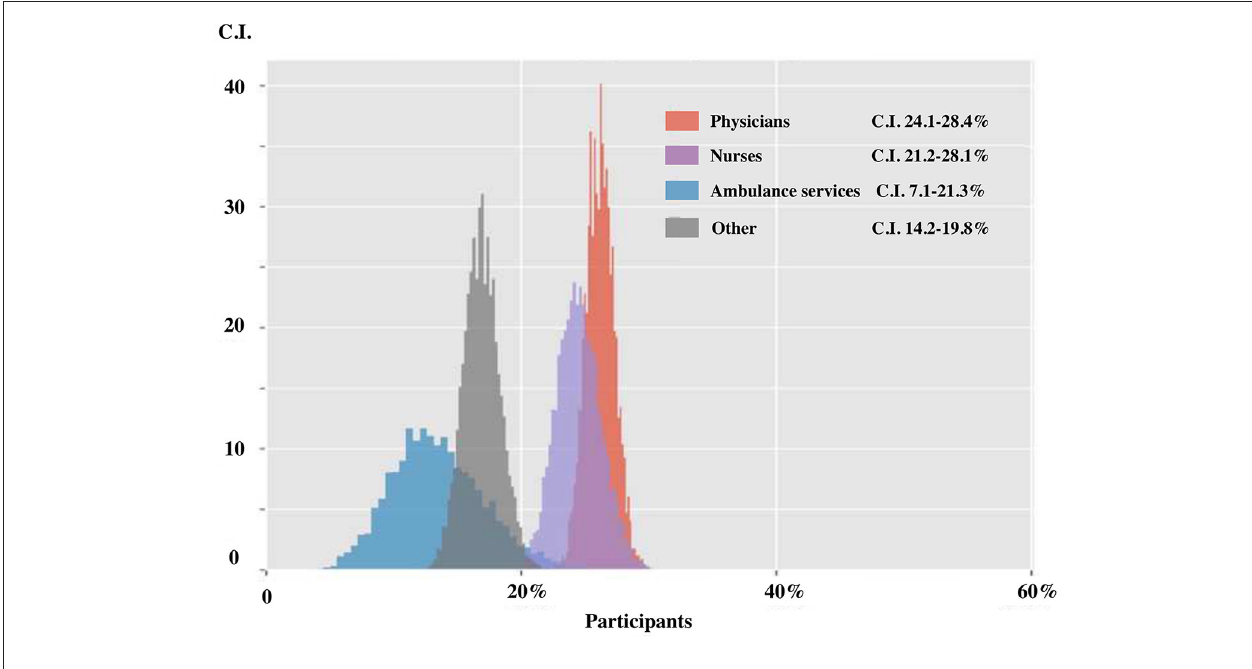
FIGURE 3 | Need for psychological support according to professional categories.